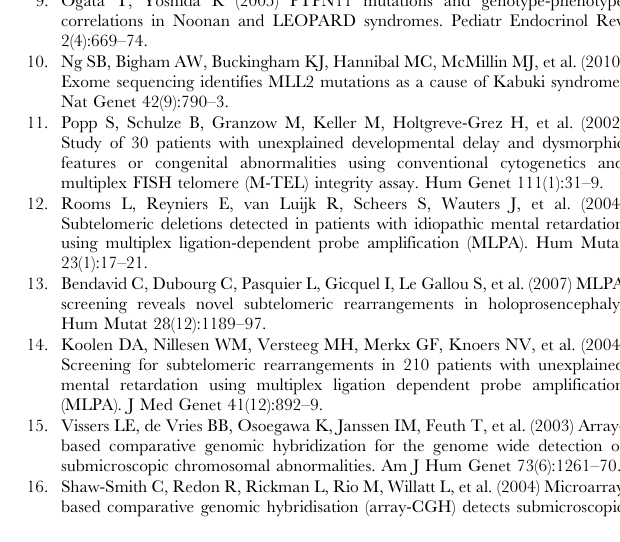
Table S2 Overview of the central nervous system malformations in 26 of the analyzed fetuses. CNS: central nervous system. Table S3 Type of renal malformations observed in 9 of the studied fetuses. Table S4 Overview of the affected organs and systems in fetuses with multiple malformations. CHD: congenital heart defect; CNS: central nervous system; IUGR: intrauterine growth restriction.